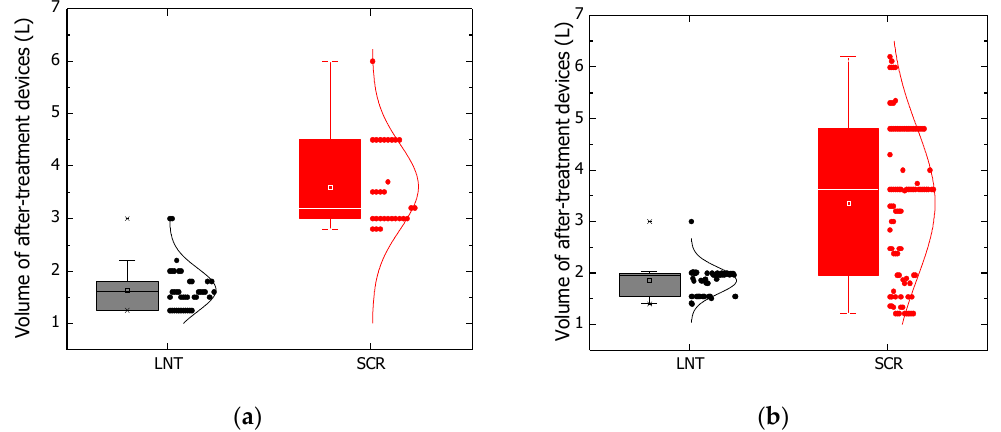
Figure 9. NO x emission characteristics according to after-treatment system and vehicle displacement for the domestic and imported vehicles in Korea. ( a ) Domestic vehicles; ( b ) Imported vehicles. Figure 10. Volume distribution of after-treatment devices (LNT and SCR) in domestic and imported Euro-6 vehicles in Korea. ( a ) Domestic vehicles; ( b ) Imported vehicles.